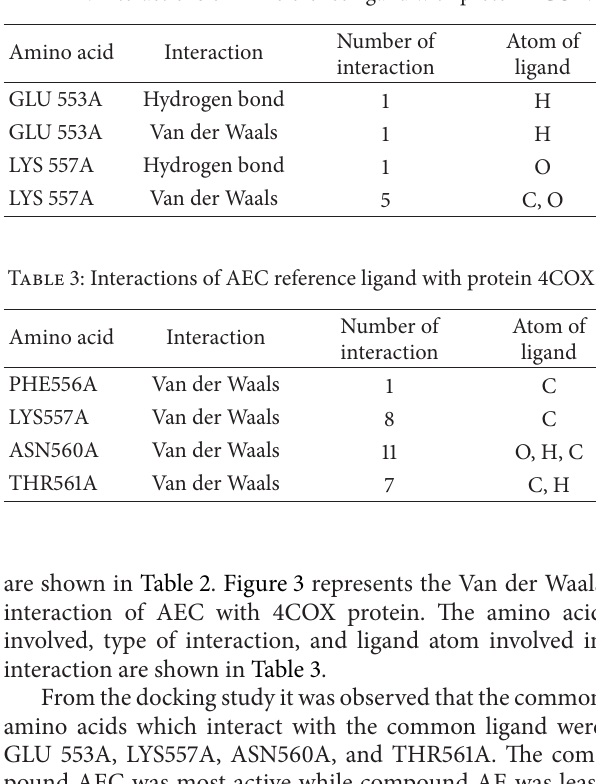
Table 2: Interactions of AE reference ligand with protein 4COX.